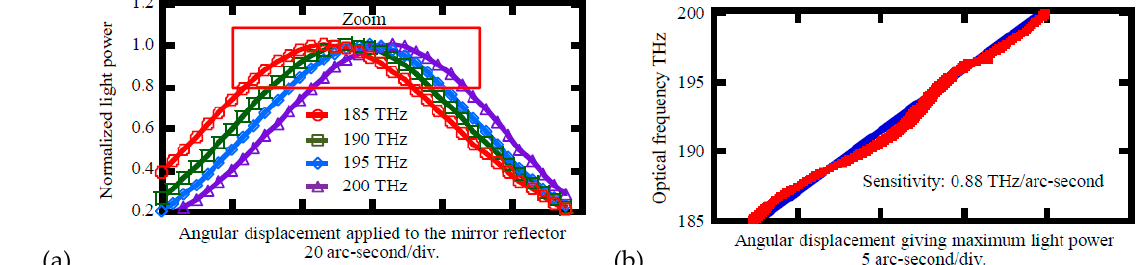
Figure 12. Optical modes captured in the setup based on the chromatic aberrations of a simple lens [58]: ( a ) Variation of the light intensities of optical modes captured by the fiber detector; ( b ) Peak optical frequency detected at each angular position of the mirror reflector.